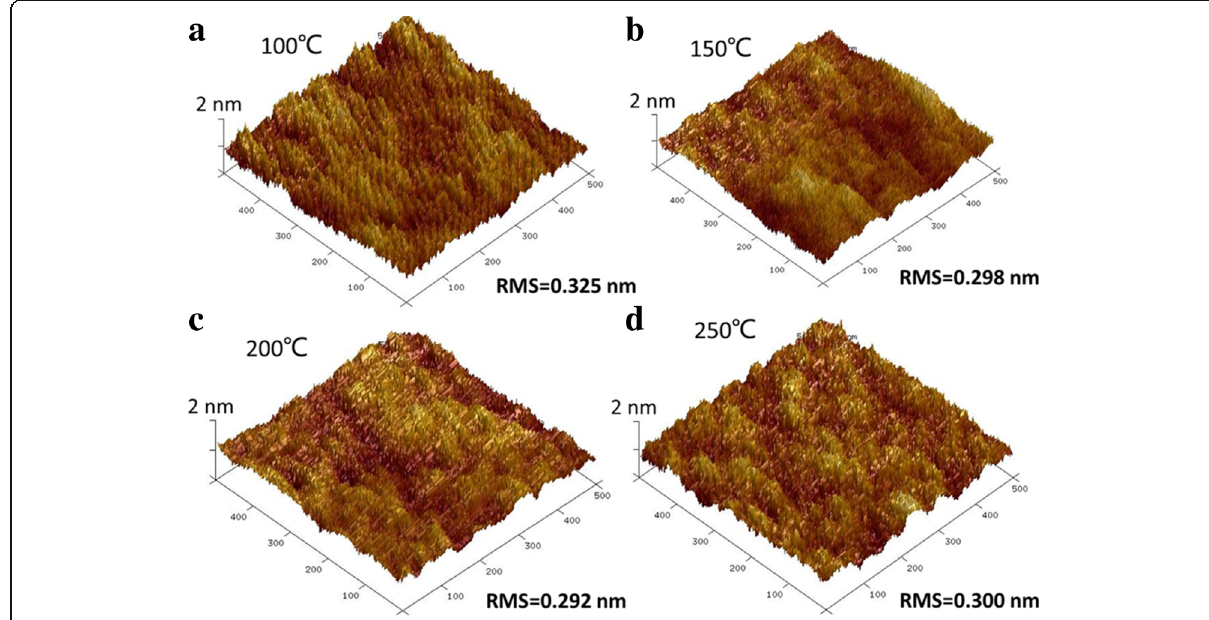
Fig. 5 AFM images of the Co films (1200 cycles) deposited with Co(EtCp) 2 pulse time of 2 s and NH 3 plasma pulse time of 10 s at different temperatures: a 100 °C; b 150 °C; c 200 °C; d 250 °C